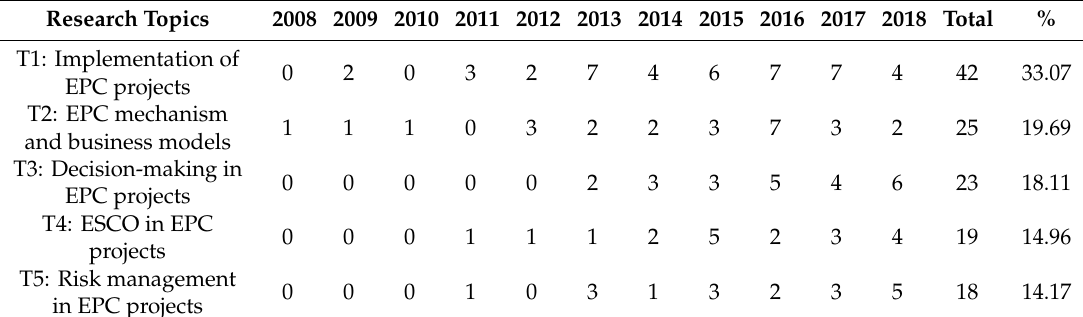
Table 4. Number of papers on di ff erent research topics